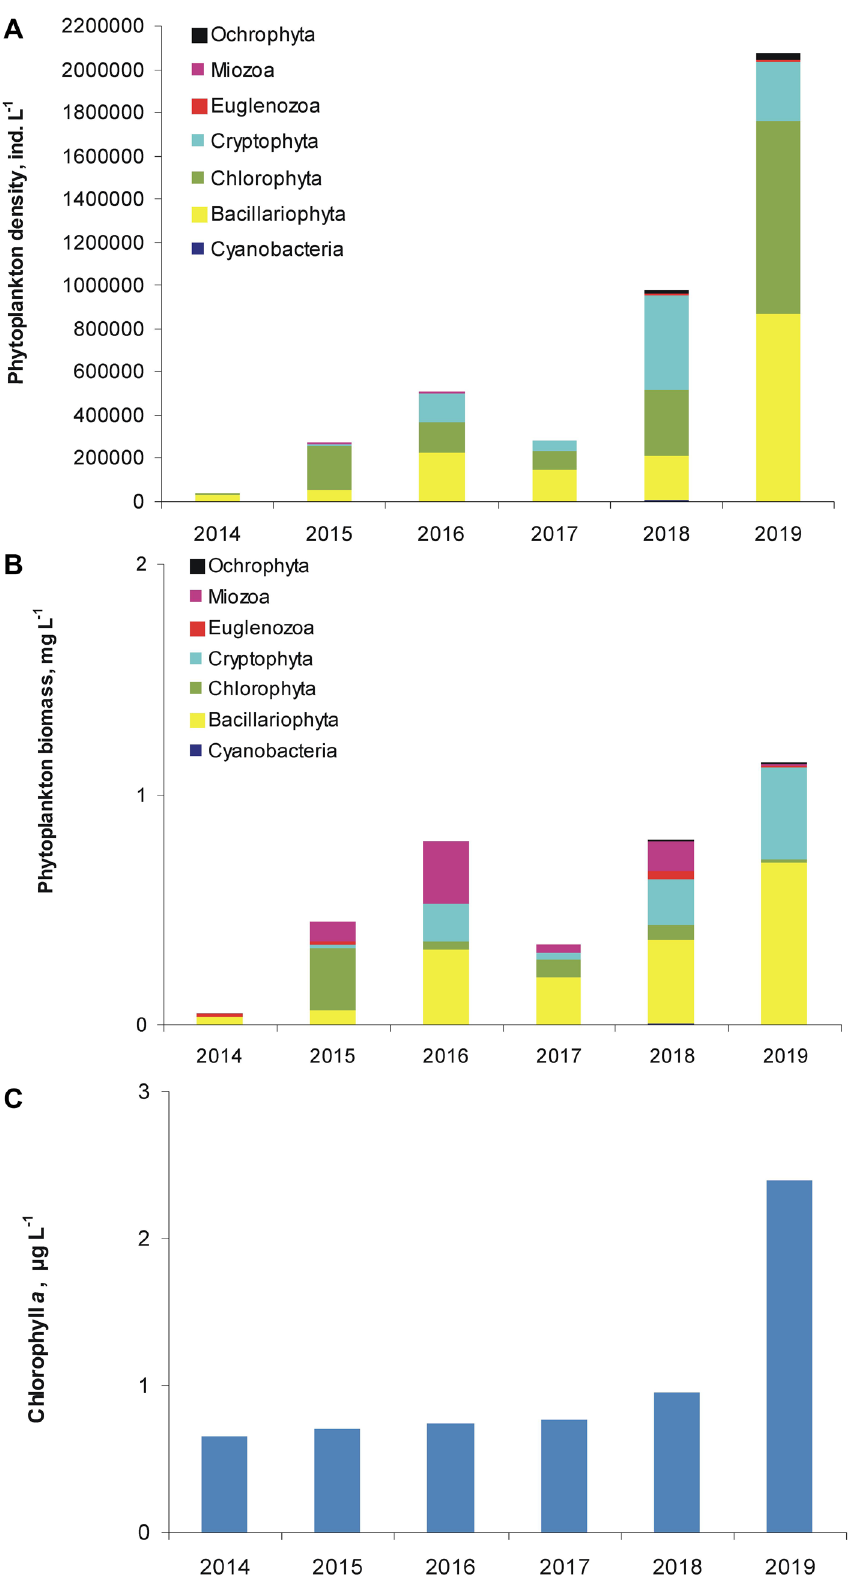
Figure 2. Phytoplankton density ( A ), biomass ( B ), and chlorophyll a content ( C ) in the Kuźnica clarification pond in 2014–2019 (seasonal